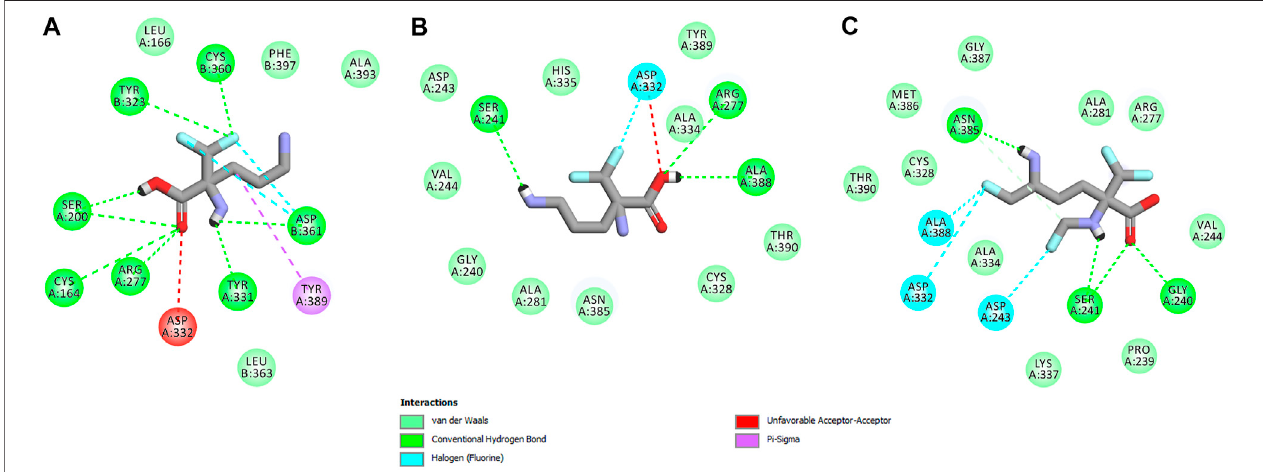
FIGURE15| Twodimensionalvisualizationoftheh-ODC(PDBID:2OO0)(Dufeetal.,2007)bindinginterfacesascomputedbyBIOVIADiscoveryStudio Visualizer 20.1.0.19295 software for top-scoring poses of the ligand molecules L -DFMO (A) , D -DFMO (B) , and DFMO-analogue (C) , respectively. Polar contacts between receptor-ligand including hydrogen bonds (green), unfavorable hydrogen bond acceptor – acceptor (AA) clashes (red), halogen bonds (cyan), and π – σ interactions (purple) are represented by dashed lines. Intermolecular Van der Waals forces are displayed in light-green spoked arcs